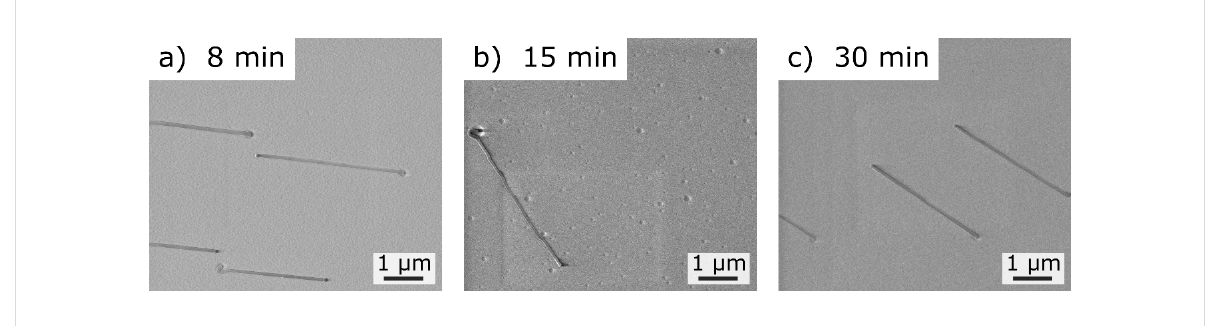
Figure 6: Growth experiments for an increased process time: variation of the process time from (a) 8 min, (b) 15 min and (c) 30 min. In our standard procedure, a-plane sapphire substrates and Au NPs (Ø 80 nm) were used at a process pressure of 20 mbar.